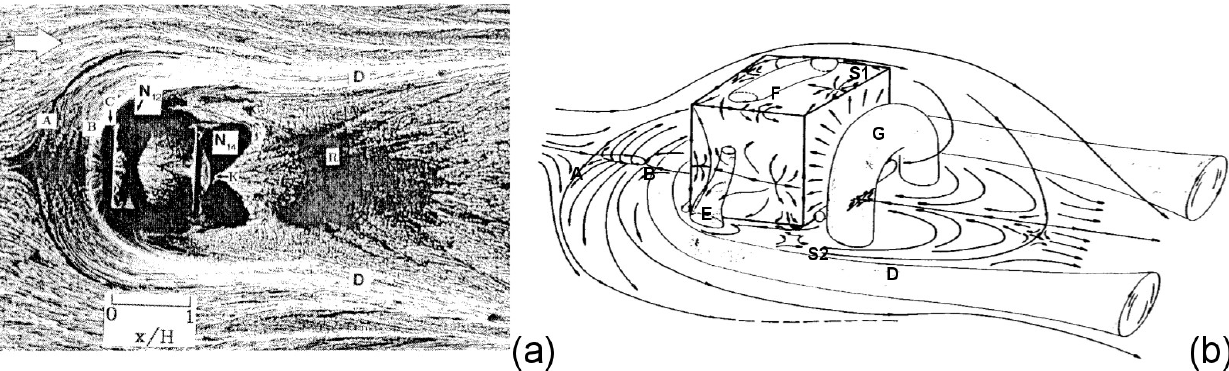
Figure 13. (a) Top visualization of the flow around a cube (Hussein and Martinuzzi, 1996); (b) schematic representation of the time-averaged vortex structure around a cube (Martinuzzi and Tropea, 1993) and index of the recirculating regions.